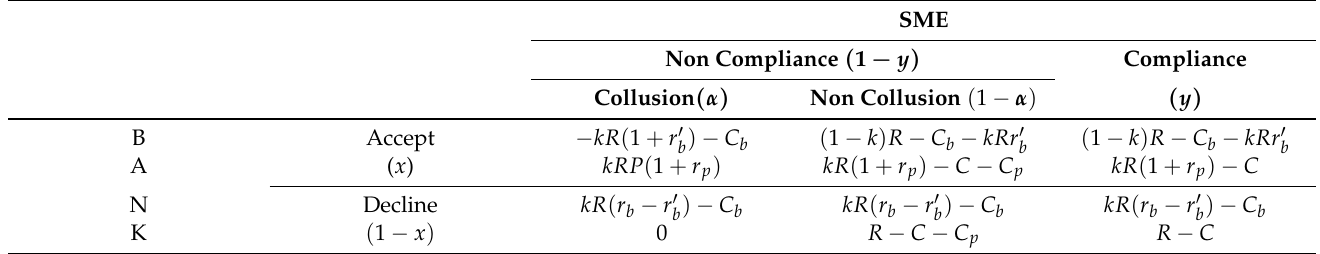
Table 1. The return matrix before introducing blockchain technology.